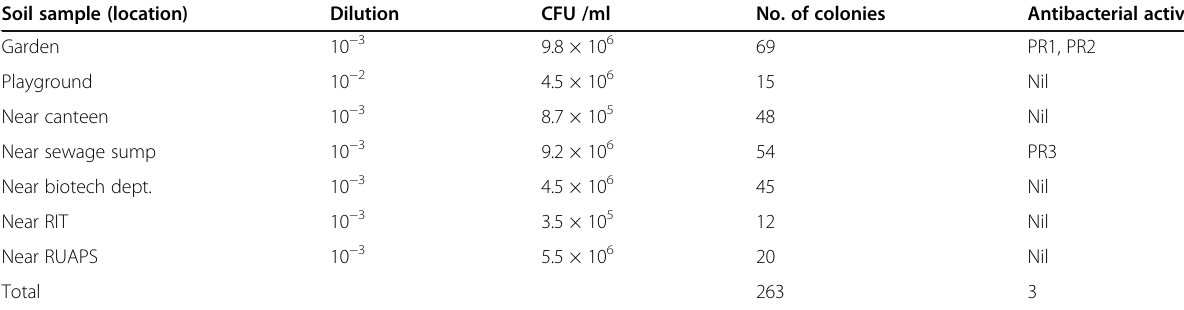
Table 1 Bacteria from soil samples Soil sample (location)